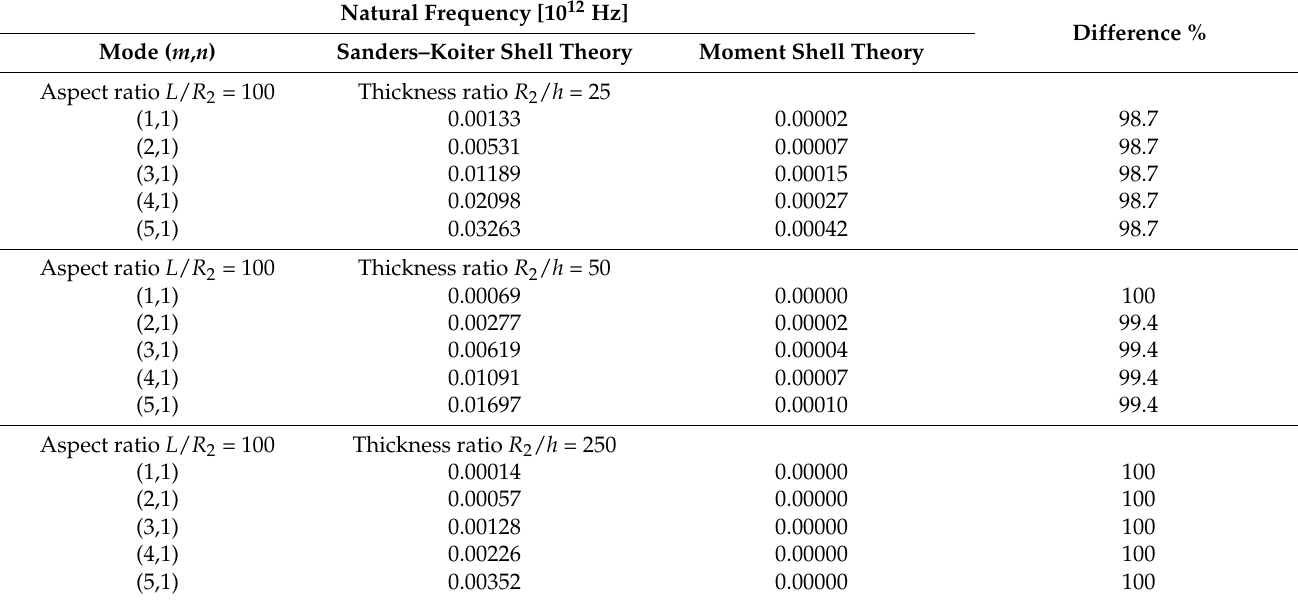
Table 14. Simply supported DWCNT with aspect ratio L / R 2 = 100 and thickness ratios R 2 / h = (25,50,250). Beam-like modes ( n = 1). Comparisons between Sanders–Koiter and moment shell